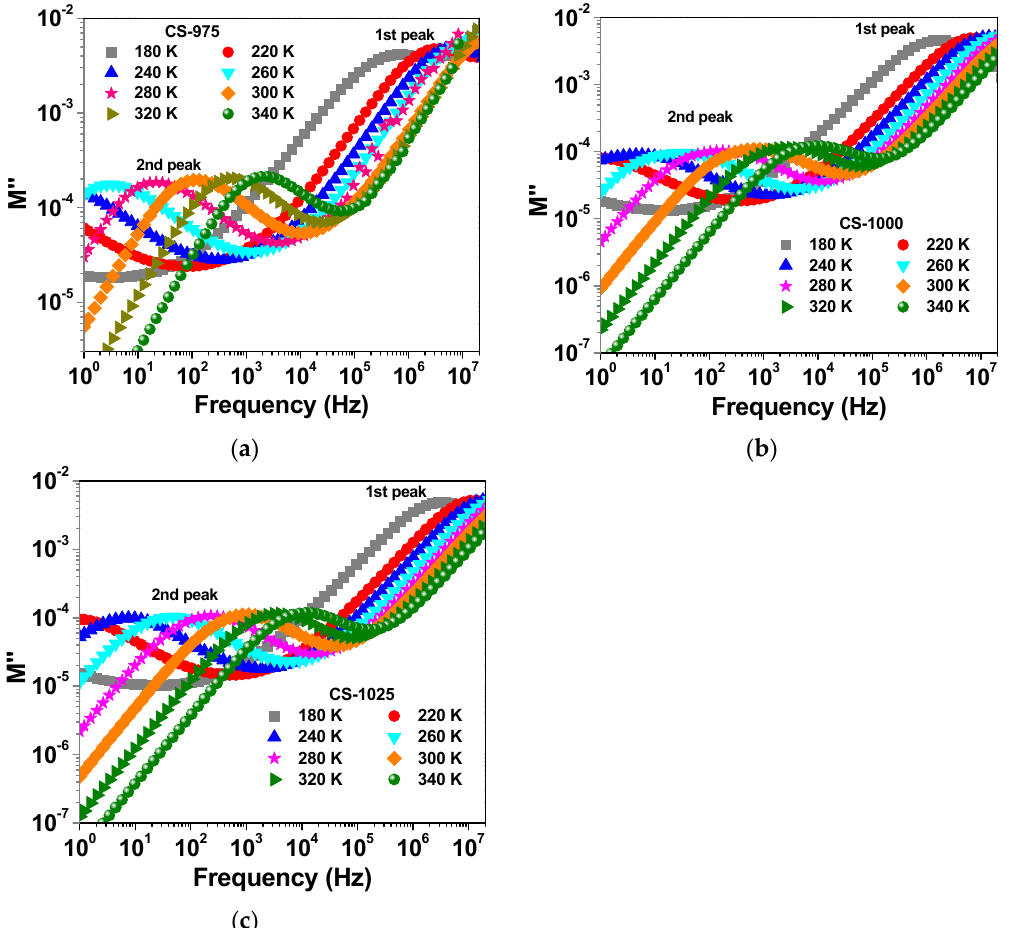
Figure 9. Modulus spectra of LCTO ceramics at selected temperatures: ( a ) CS-975, ( b ) CS-1000, and ( c ) CS-1025.